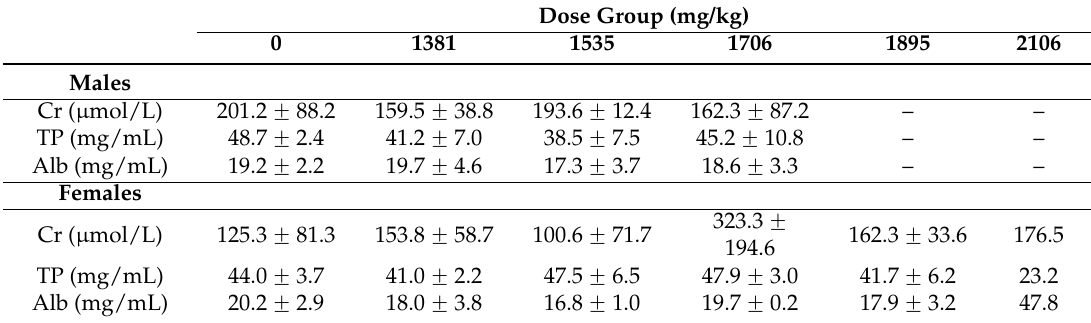
Table 3. Effects of SalB-Rg1 with a single dose on the biochemical parameters in acute toxicity. Dose Group (mg/kg)